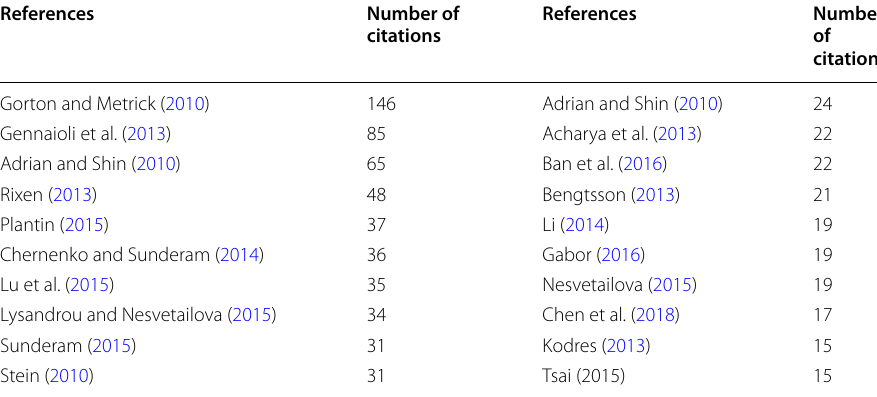
Table 2 Highest cited documents on